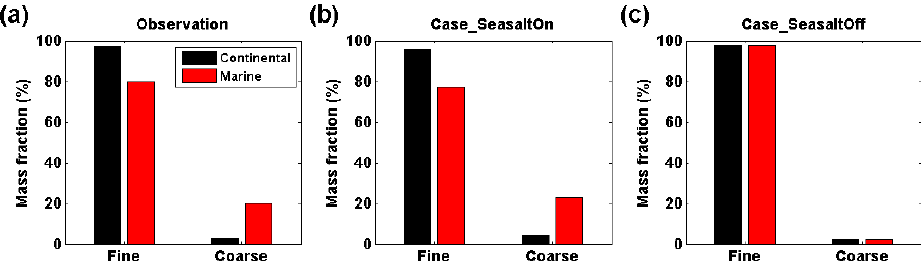
Figure 4. Observed and simulated mass fraction of particulate nitrate in fine and coarse modes at Melpitz, Germany. (a) Observation based on the Berner impactor measurements. (b) WRF-Chem Case_SeasaltOn simulation, i.e., with sea-salt emission. (c) WRF-Chem Case_SeasaltOff simulation, i.e., without sea-salt emission. The results are grouped into continental (black bar) and marine (red bar) air mass types. According to the size-cuts of the Berner impactor, the size ranges of the fine- and coarse-mode particles are defined as PM 1 . 2 (particles with an aerodynamic diameter smaller than 1.2µm) and PM 1.2–10 (particles with an aerodynamic diameter larger than 1.2µm and smaller than 10µm),